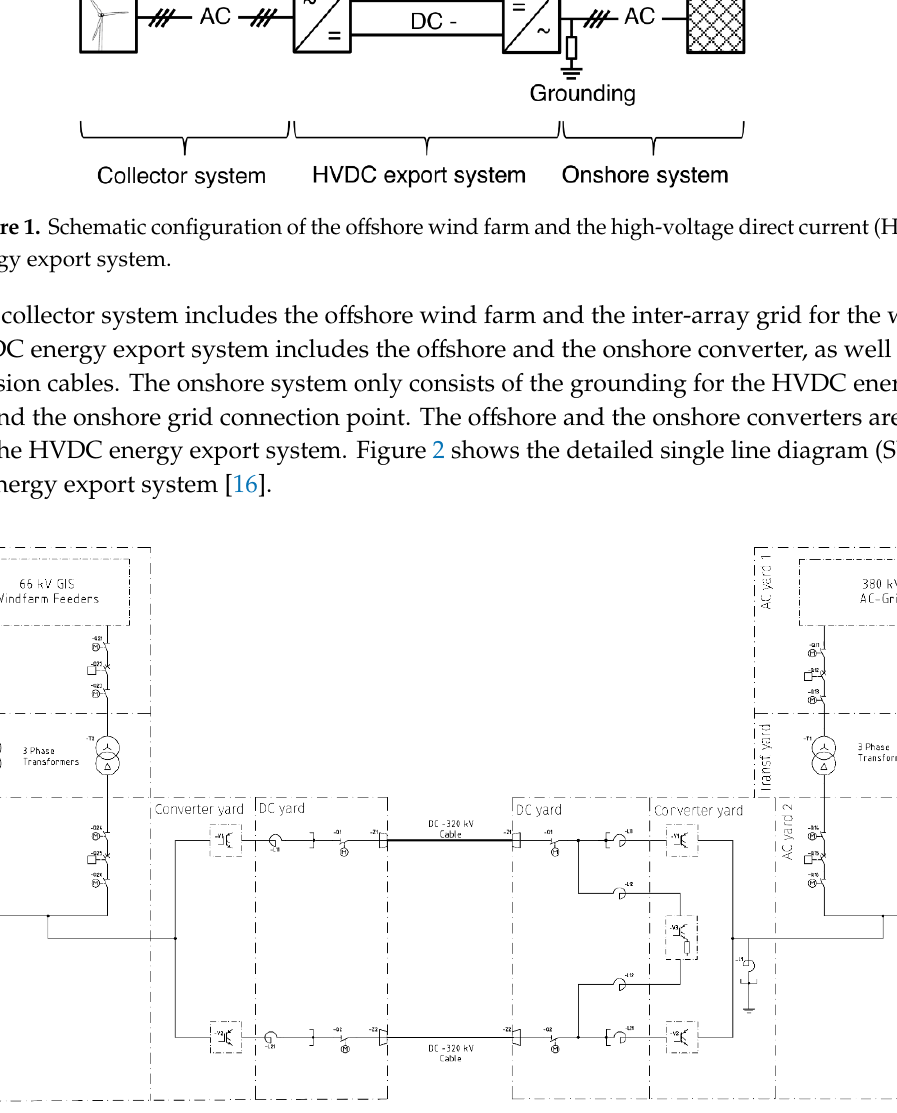
Figure 2. Single line diagram (SLD) of the HVDC energy export system and maintenance areas for the onshore and offshore station.